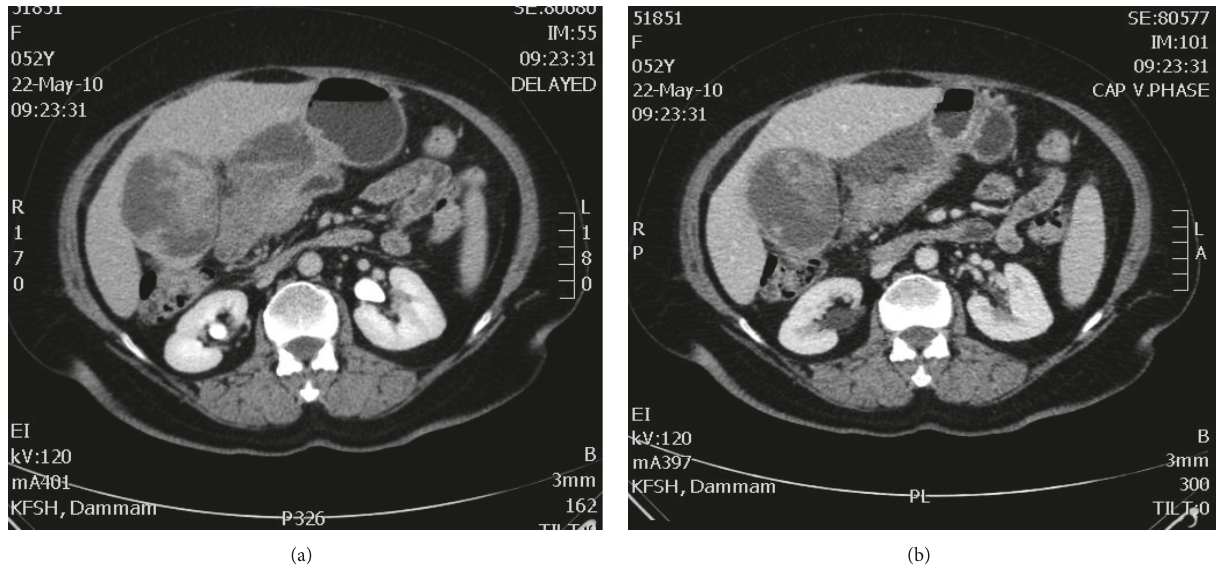
Figure 1: (a) and (b) Abdominal CT scan demonstrating a large exophytic mass within the